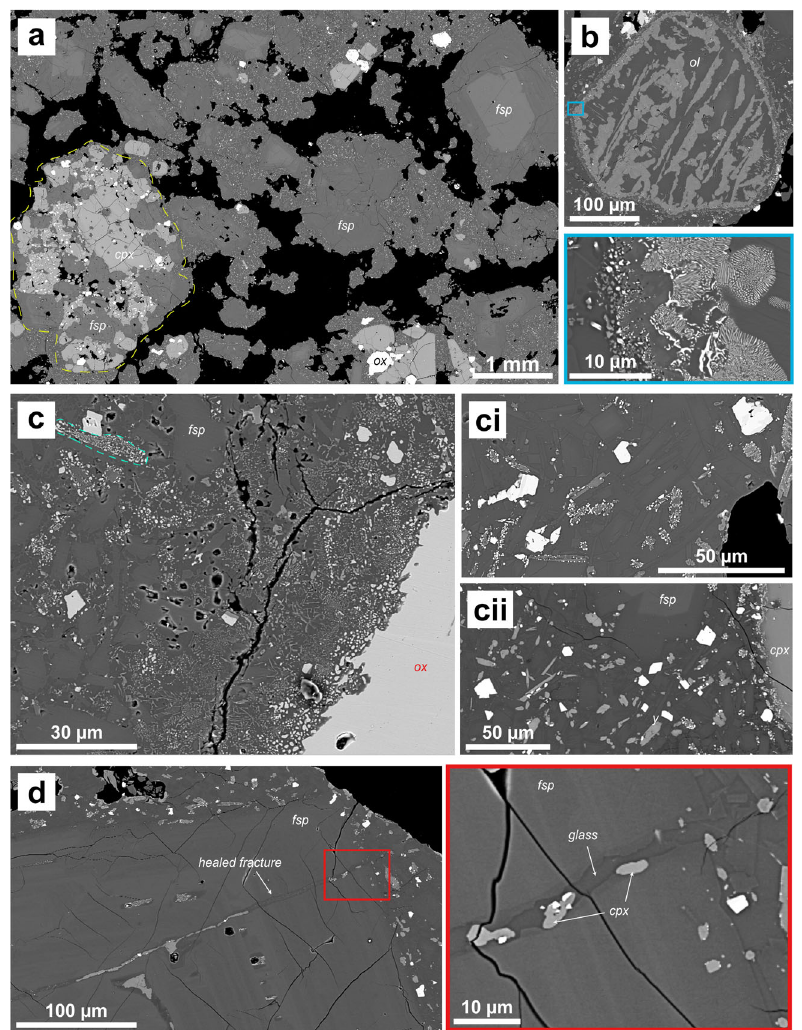
Fig. 8 Backscattered electron images of the 2021 lava dome. Five full thin section image maps, acquired on a Zeiss Gemini 300 SEM at the University of East Anglia, UK, were generated from clasts sampled in January 2021 from the growing dome and analysed to identify common textures as displayed in a – d . a Image showing vesicular nature of the dome sample (vesicles in black) with examples of the crystal population labelled: plagioclase (fsp), clinopyroxene (cpx), Fe-Ti oxides (ox) and gabbroic clots (outlined by yellow dashed line). b Example of heavily degraded olivine (ol) (blue box) shows close-up of this texture. c Examples of localisation of degradation of orthopyroxene crystals to oxides (dashed turquoise line in c ). Higher levels of degradation observed close to larger oxides (e.g. image c and ci, x) comprises ~5% of each thin section. Elsewhere, orthopyroxenes are un-degraded (cii, y). d Example of a plagioclase phenocryst (fsp) with a fracture that has been later fi lled by melt and crystals, this is observed several times across the fi ve sections analysed. Red box shows a close-up of this structure showing clinopyroxene, oxides and glass in fi lling the